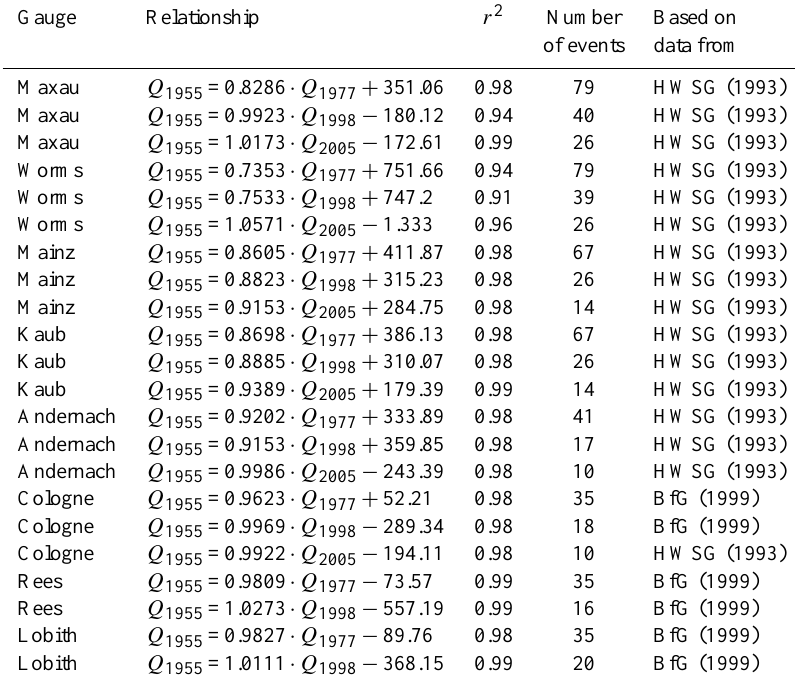
Table 1. Homogenisation relationships for Rhine gauges for different stages of river training. Number of events indicates the sample size of historical events used to derive a homogenisation